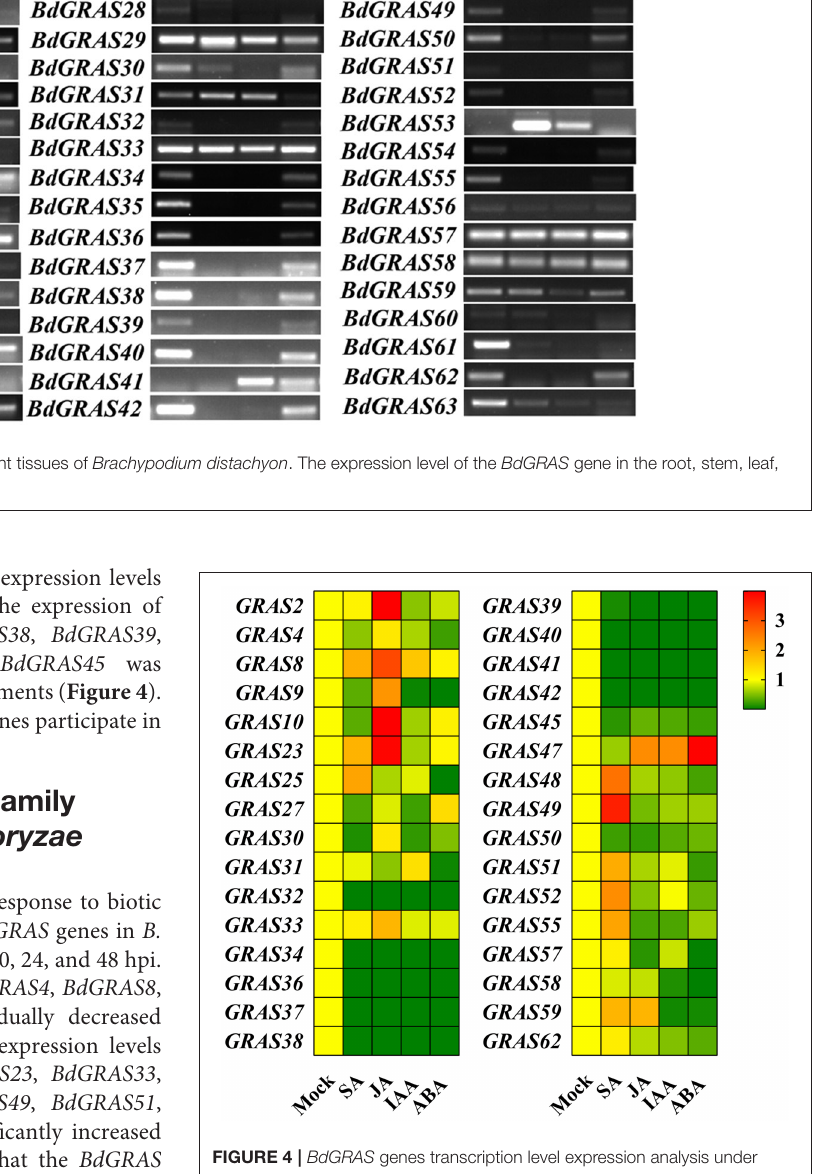
FIGURE 4 | BdGRAS genes transcription level expression analysis under different hormone treatments. The changes of BdGRAS genes expression levels in B. distachyon under salicylic acid (SA), jasmonic acid (JA), indoleacetic acid (IAA), and abscisic acid (ABA) treatments at 1 hpi. Green and red represent relatively low and high expression